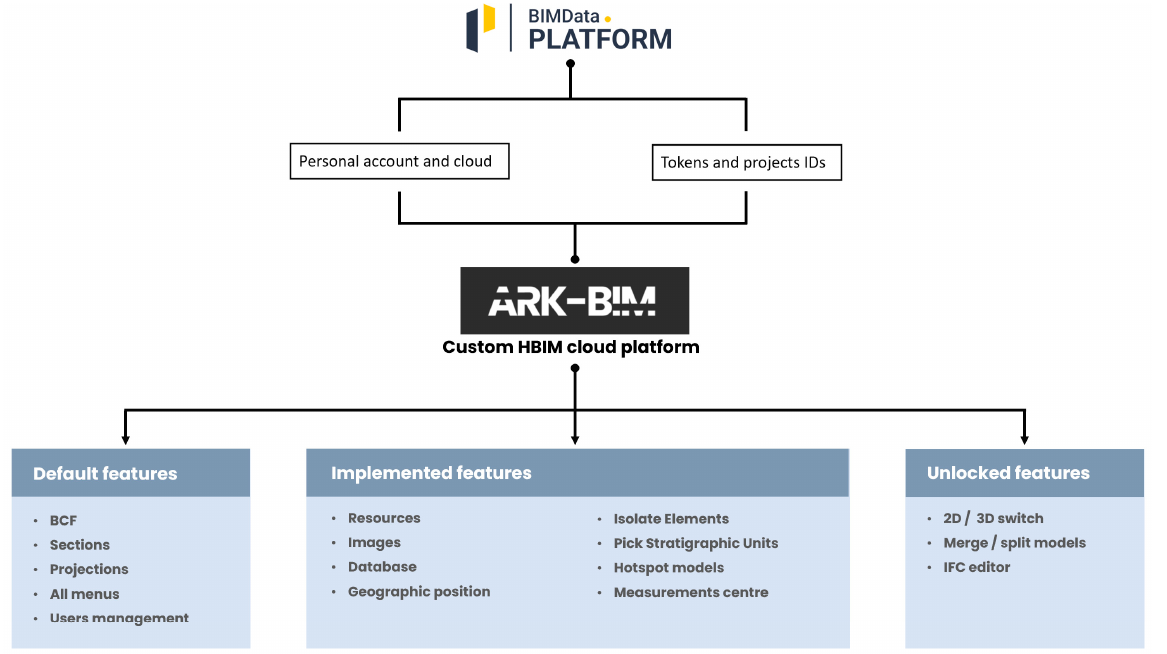
Figure 11. From the BIMData platform to ARK-BIM development: default, implemented and unlocked features inside the new